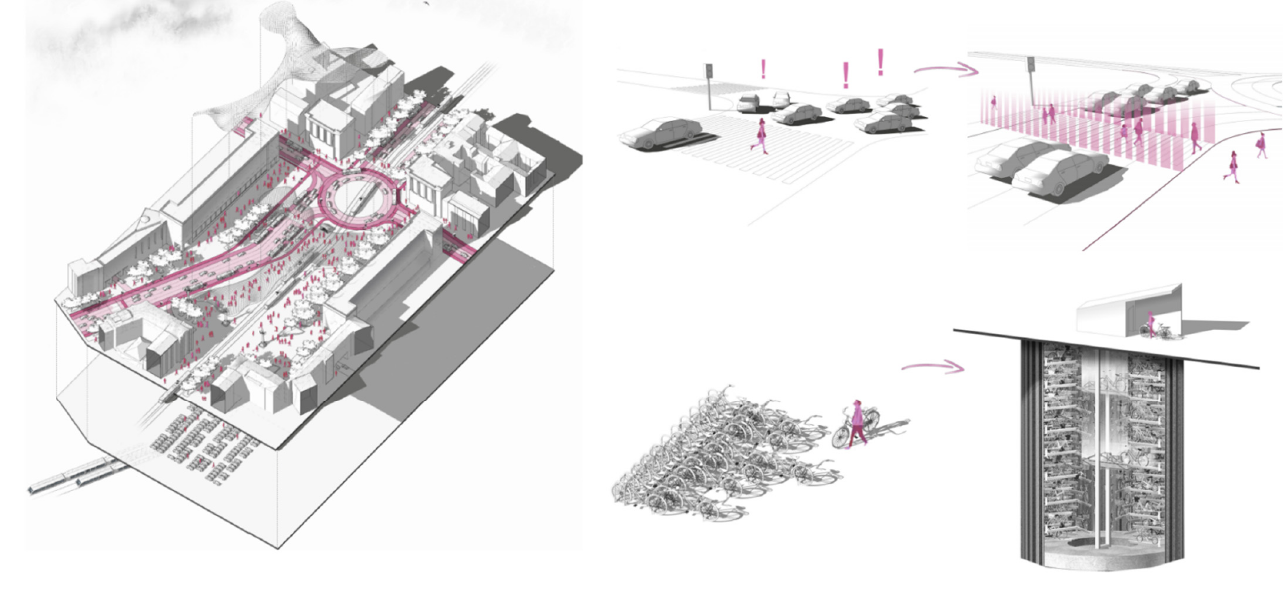
Figure 5. ( Left ) The plan of the future Constitution Square, including the reorganization of the road traffic, the implementation of a new metro station and the transfer of car and bicycle parking space underground [27]. ( Right , top ) The usage of the hologram traffic lights for the improvement of the safety of pedestrians. ( Right , bottom ) A multi-level, automated parking solution for bicycles and other small vehicles.